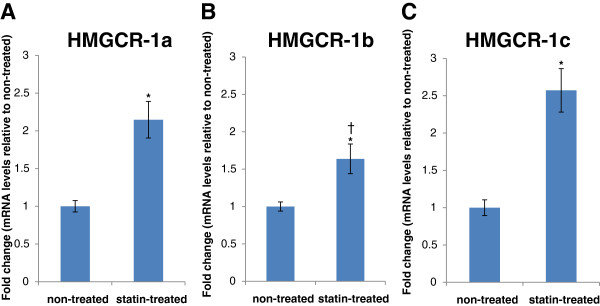
Upregulation of HMGCR transcript variants in HepG2 cells treated with atorvastatin. HepG2 cells were incubated in culture medium with lipoprotein deficient serum (LPDS; non-treated) and 10 μM atorvastatin + LPDS for 24 h (treated). The mRNA levels of (A) HMGCR-1a (B) HMGCR-1b and (C) HMGCR-1c were measured by RT-qPCR using exon1-specific primers and a set of validated reference genes for normalisation. The results are shown as the mean fold-change compared with mRNA levels in non-treated cells. Error bars indicate standard errors (± S.E), n = 5. *Statistically significant differences between non-treated and treated (p < 0.05) were determined using Student’s t-test. †The magnitude of statin-induced upregulation of HMGCR-1b was significantly lower (p < 0.05) than that of HMGCR-1a and HMGCR-1c, respectively, as determined by a paired-sample Student’s t-test.